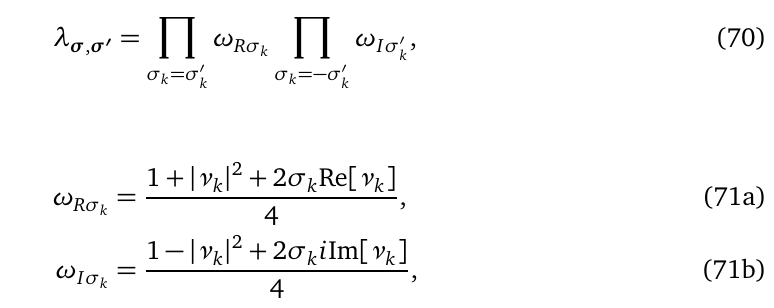
= (cid:96) = (cid:96) and 20 ≤ (cid:96) ≤ 200 1 2